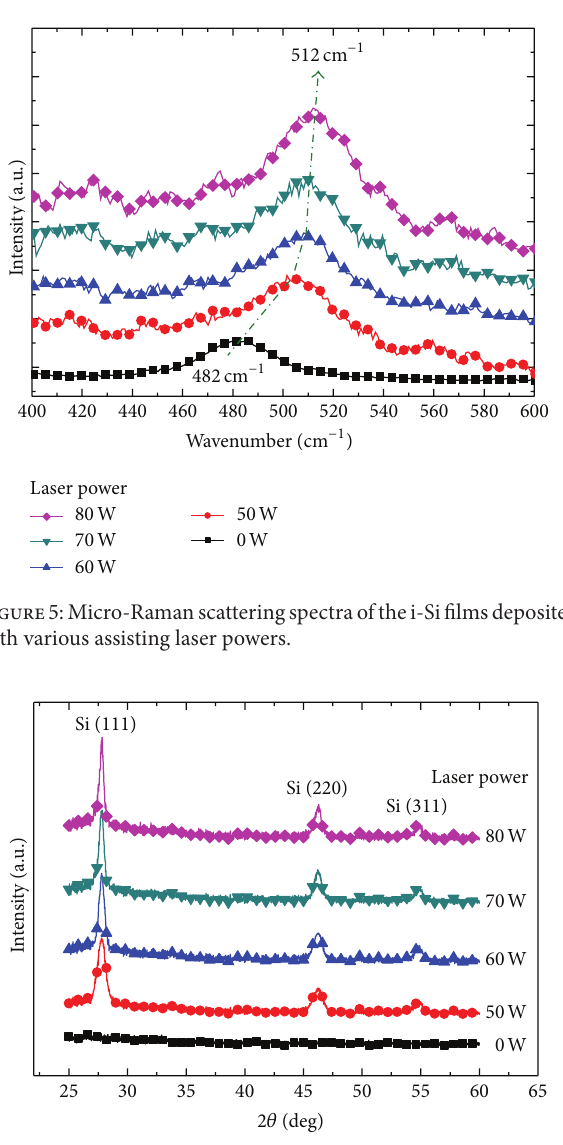
Figure 6: XRD spectra of the i-Si films deposited with various assisting laser powers.